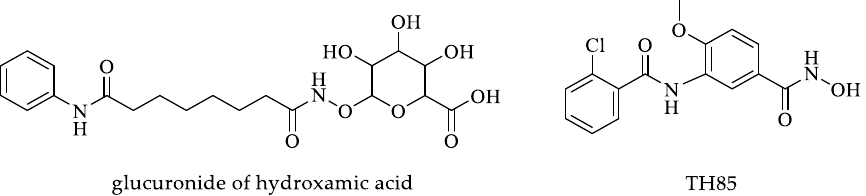
Figure 8. HDAC inhibitors as potent antileishmanial agents with low cytotoxicity.